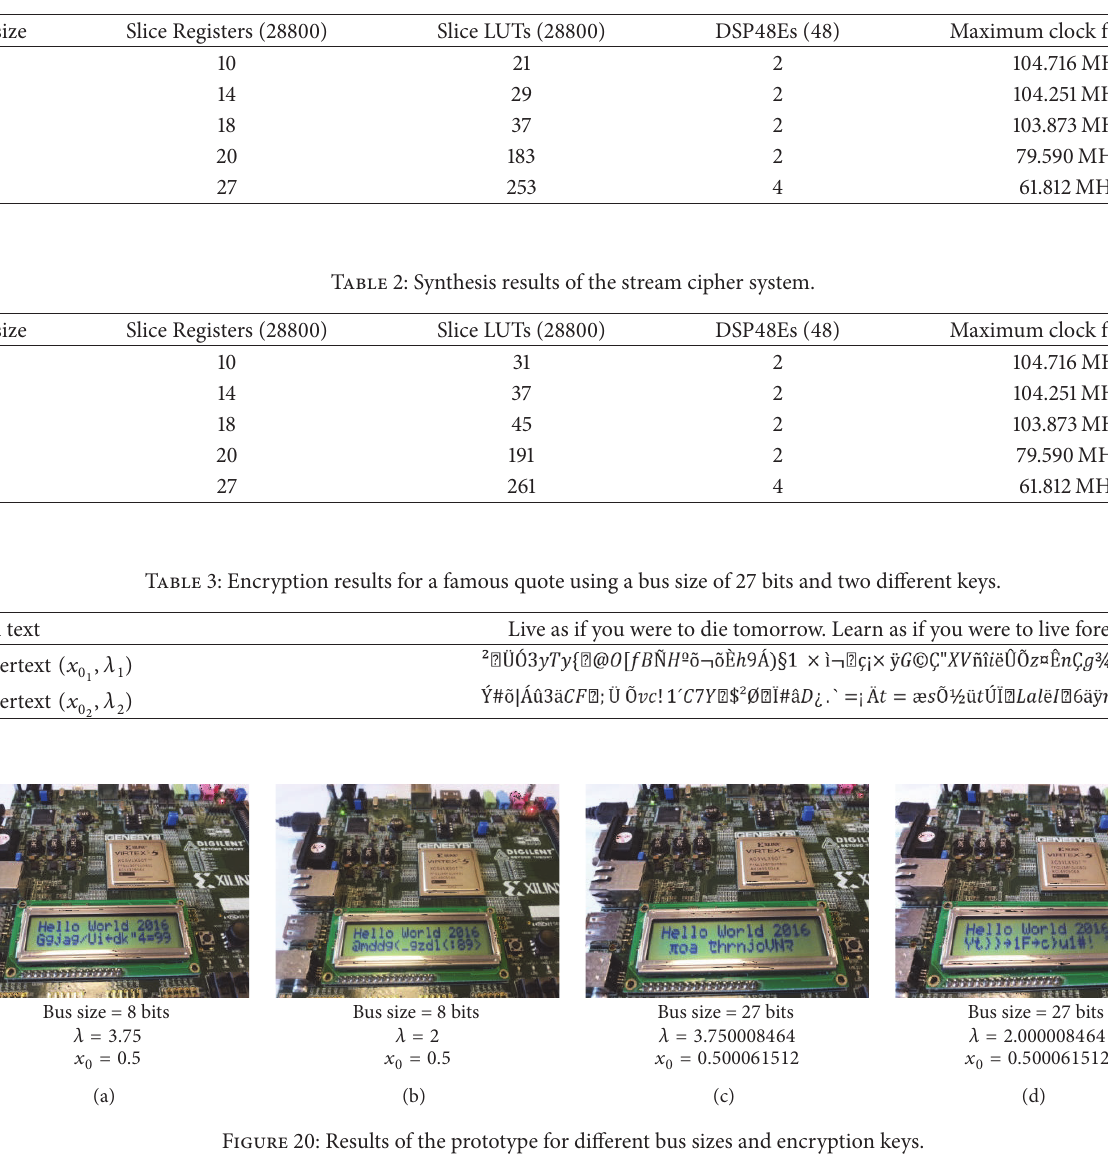
Table 1: Synthesis results for the logistic map using different bus sizes.